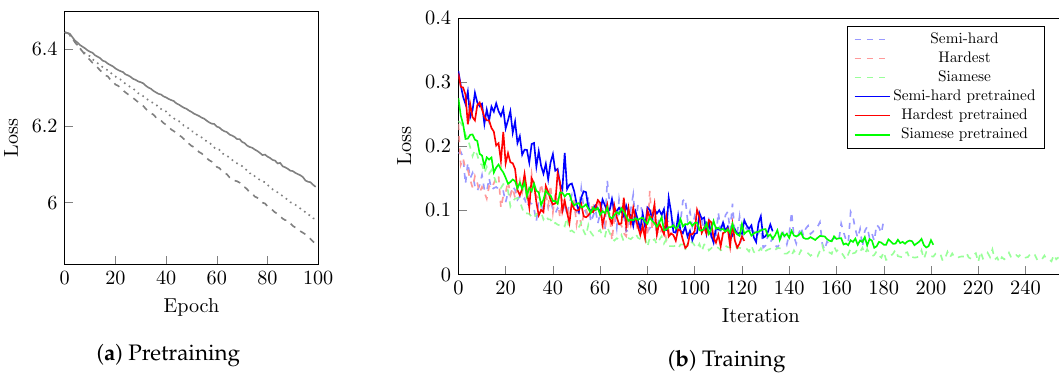
Figure 10. Loss over time when training ResNet-18 using the MDIPFL50 transforms of the extracted samples of the ATS-CVPR2016 dataset. Subfigure ( a ) shows the linear pretraining loss, while subfigure ( b ) visualizes the contrastive and triplet loss over iterations for different setups.